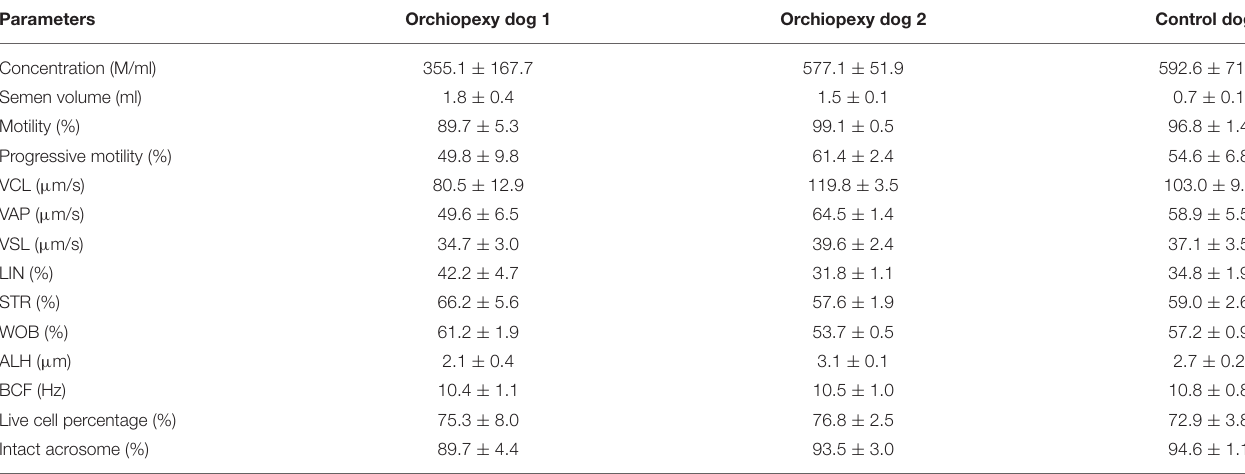
TABLE 2 | Kinematic parameters, live cell, and intact acrosome percentages in orchiopexy and control dogs.